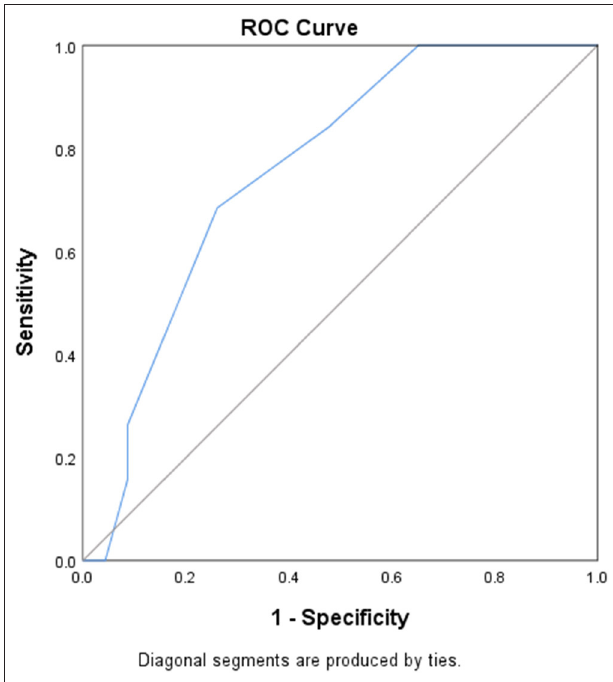
FIGURE 1 | ROC curve of the risk factors. Diagonal segments are produced by ties.